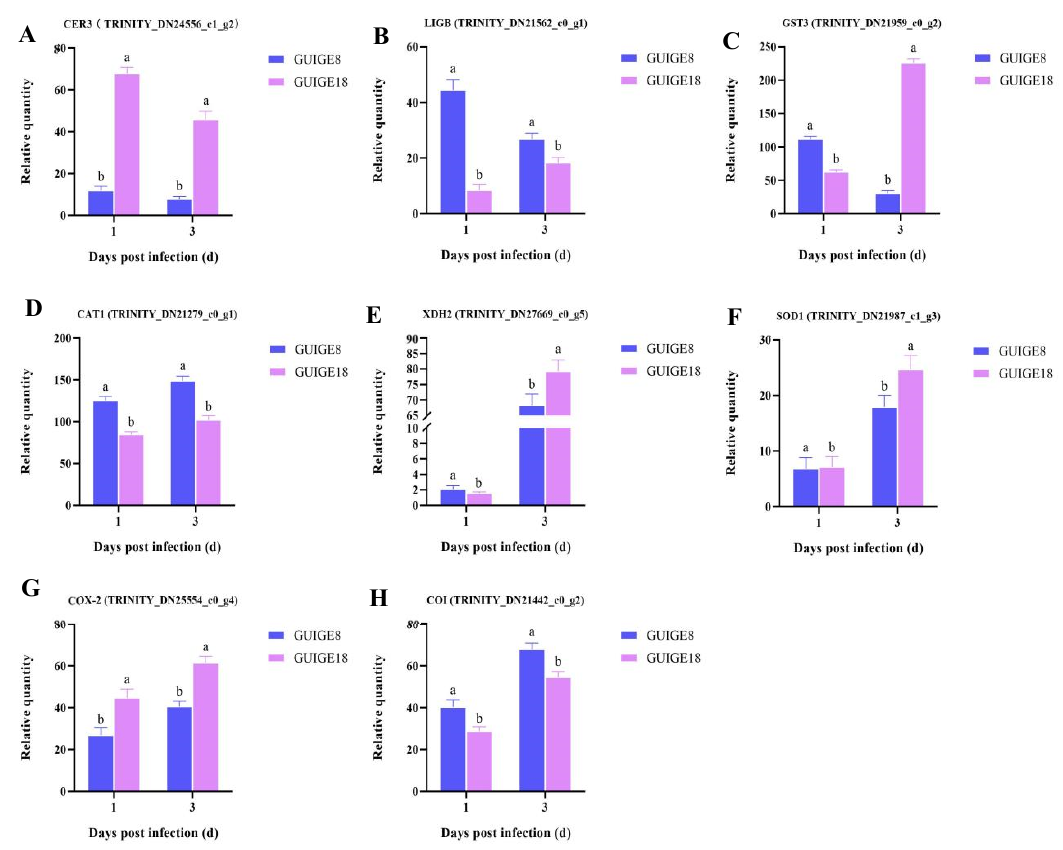
Figure 6. The expression of DEGs related to the oxidation-reduction process. ( A ) CER3; ( B ) LIGB; ( C ) GST3; ( D ) CAT1; ( E ) XDH2; ( F ) SOD1; ( G ) COX-2; and ( H ) COI. The Y axis shows the relative quantity means of three independent replicates, calculated using the 2 − △△ Ct method. Letters ‘a/b’ to indicate difference changes between the two cultivars on the same day ( p < 0.05), according to Duncan’s multiple range test using SPSS software.